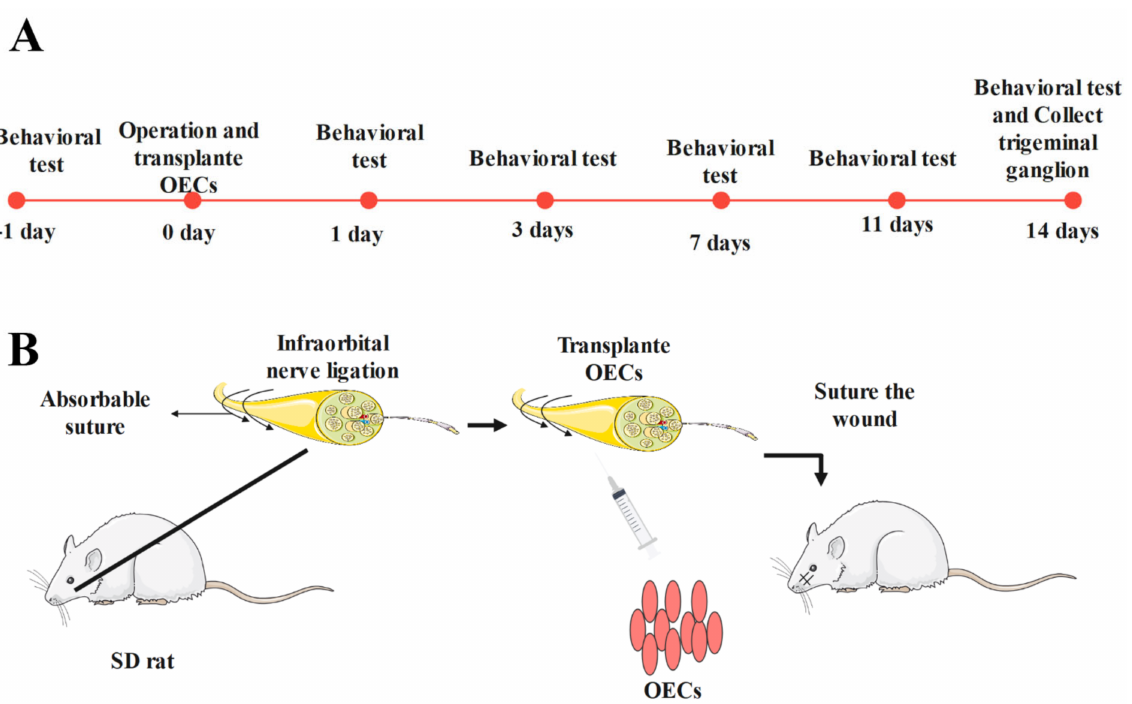
Figure 1. Experimental method: ( A ) Experimental timeline. In this part, we show the process of our animal experiment. Two to three days before the formal experiment, we conducted behavioral training on all animals to make them adapt to facial mechanical stimulation. Subsequently, behavioral tests were performed by an independent group on Days 1, 3, 7, 11, and 14 after operation; ( B ) ION–CCI operation in the rats and transplantation of OECs. For the operation, we anesthetized the rats and the infraorbital nerve was exposed carefully. After ligation, we transplanted OECs into the nerve surface and carefully sutured the muscle and skin to prevent the overflow of